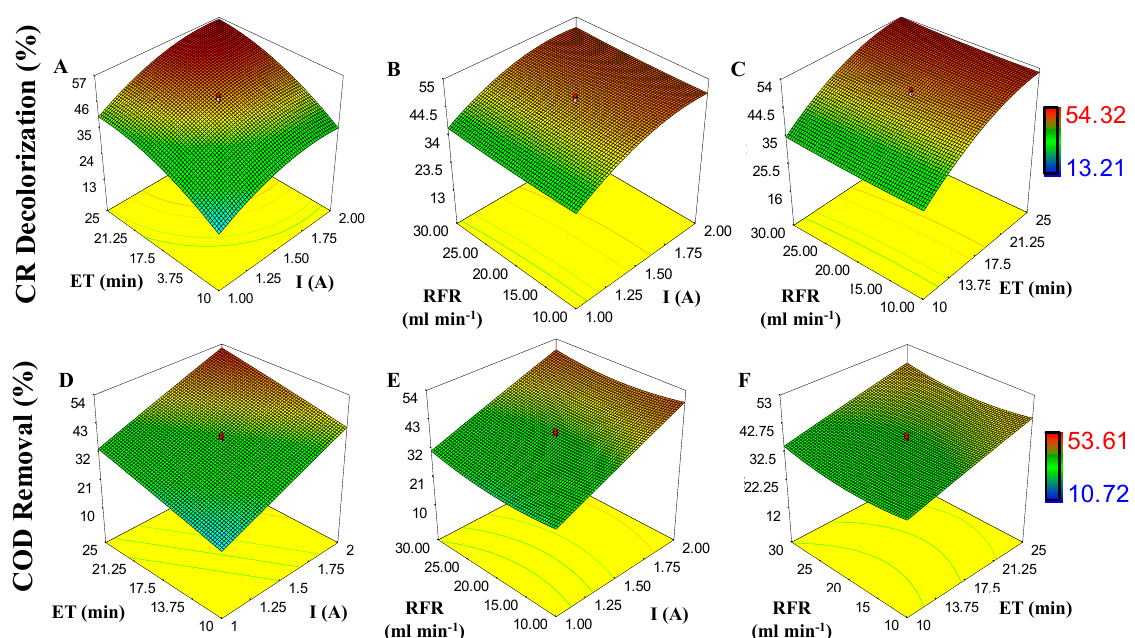
Figure 5. Effect of independent variables (I, X1; RFR, X2, and ET, X3) on response variables (CR decolorization and COD removal) during electrocoagulation process (EC): ( A ) ET and I on CR decolorization; ( B ) RFR and I on CR decolorization; ( C ) ET and RFR on CR decolorization; ( D ) ET and I on COD removal; ( E ) RFR and I on COD removal; and ( F ) RFR and ET on COD removal.